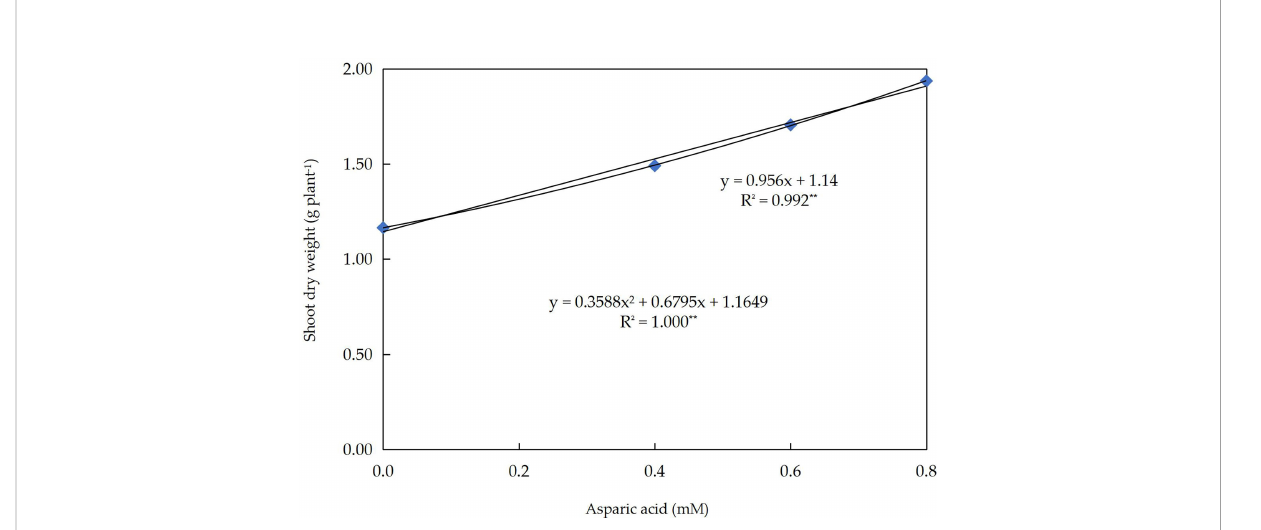
FIGURE 2 The response curve of shoot dry weight (g plant – 1 ) to different application levels of aspartic acid (mM) in wheat plants grown under three levels of 0, 30, or 60 mM NaCl salt stress for 60